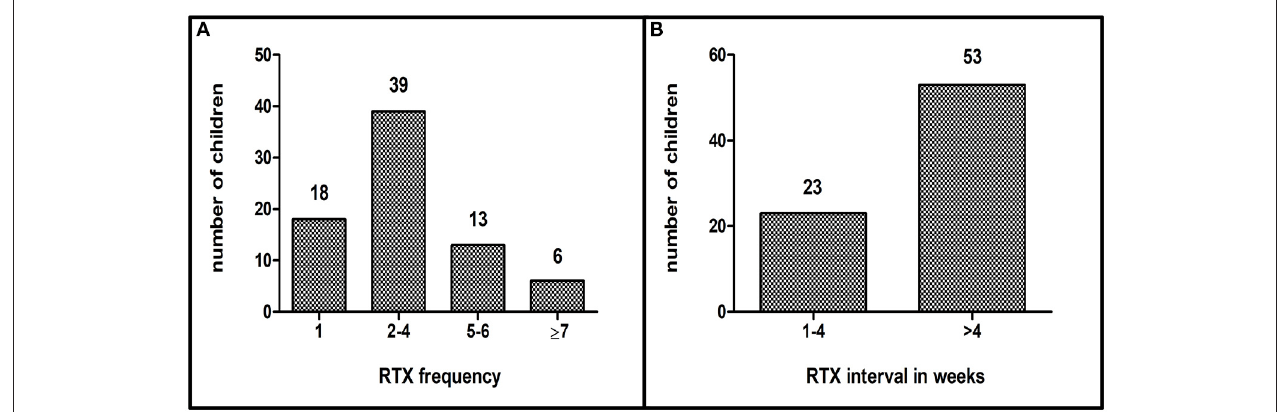
FIGURE 1 | (A) : Application frequency of RTX, (B) : Application intervals of RTX in weeks ( n = 76).